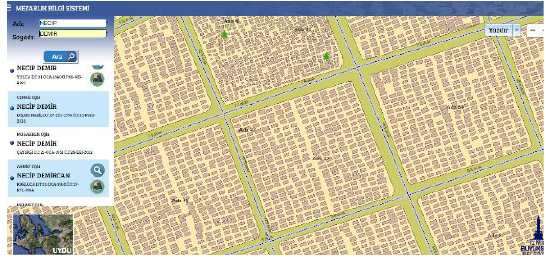
Figure 1. GIS map of Izmir